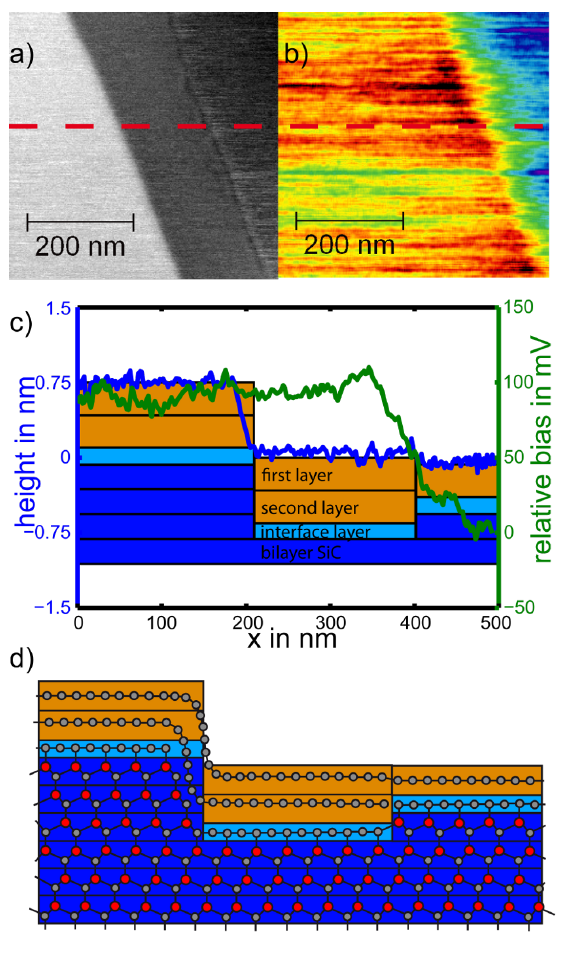
Figure 3: (a) Topographic image showing two steps found typically on samples prepared in an argon atmosphere. (b) Corresponding image of the contact potential difference. Note that only the small step in (a) coincides with a shift in contact potential. (c) Topography (blue) and contact-potential (green) profiles taken along the dashed line in (a). Underlying is a schematic illustration of the corresponding substrate composition. Different layers are drawn to their corresponding step height as SiC(0001) bilayer (0.25 nm, blue), interfacial layer (unknown height, light blue), and graphene layer (0.33 nm, orange). (d) Schematic atomic model of the surface structure, showing SiC